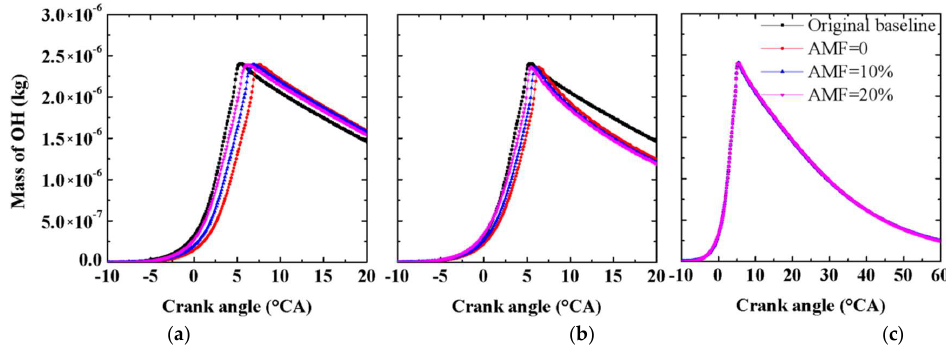
Figure 6. Mass of OH radicals at different DI timings with variation of AMF: ( a ) DI timing = −105 °CA; ( b ) DI timing = 0 °CA; ( c ) DI timing = 40 °CA.